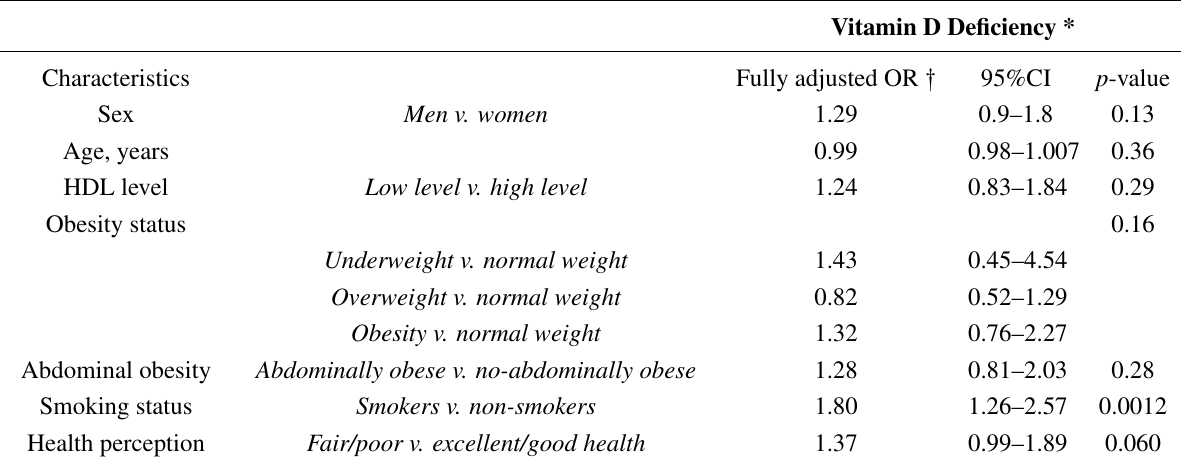
Table 2. Independent demographic, socioeconomic, and behavioral correlates of vitamin D deficiency in adults’ participants to the ORISCAV-LUX study, as identified by multivariate logistic regression ( n = 1277 subjects).